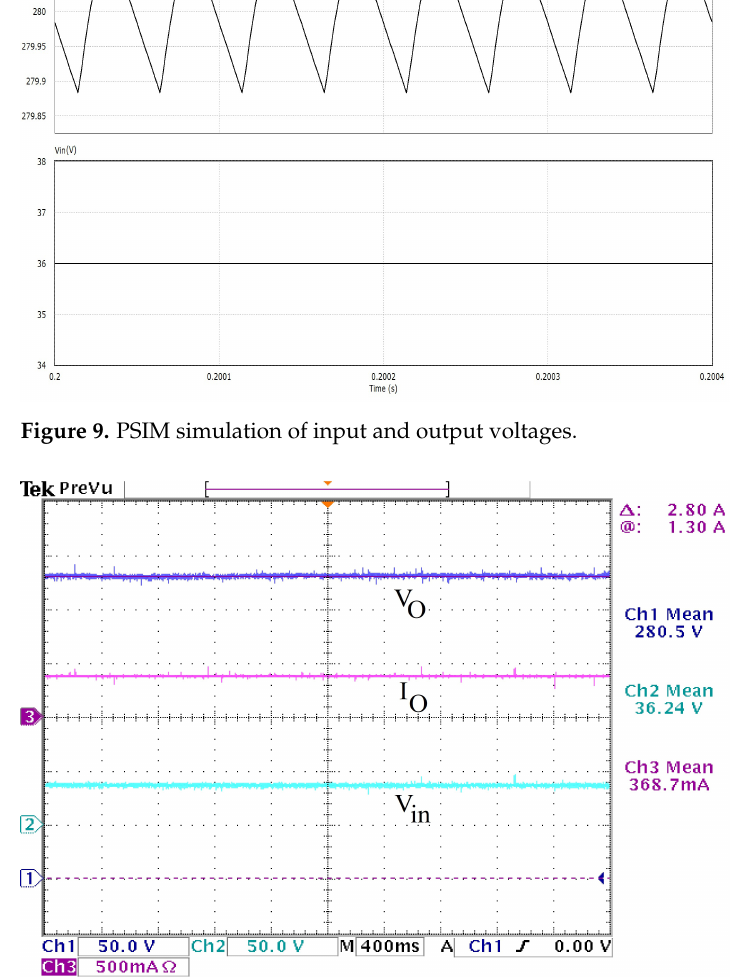
Figure 10. Input voltage, output voltage and output current.